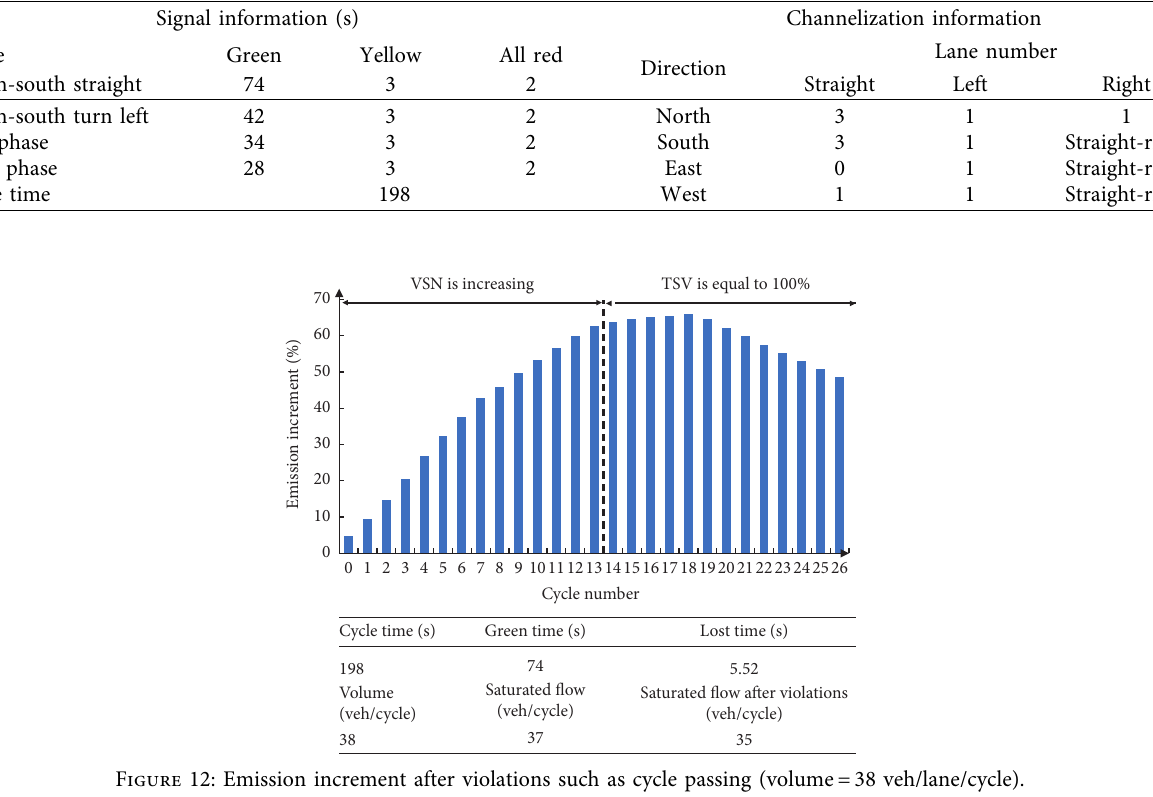
Table 2: Signal and channelization information of case intersection.